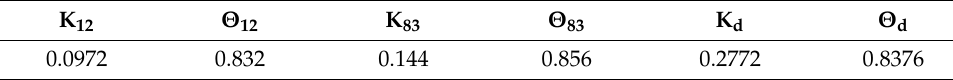
Table 7. Theory optimal parameter combination of COD, AN and TP.